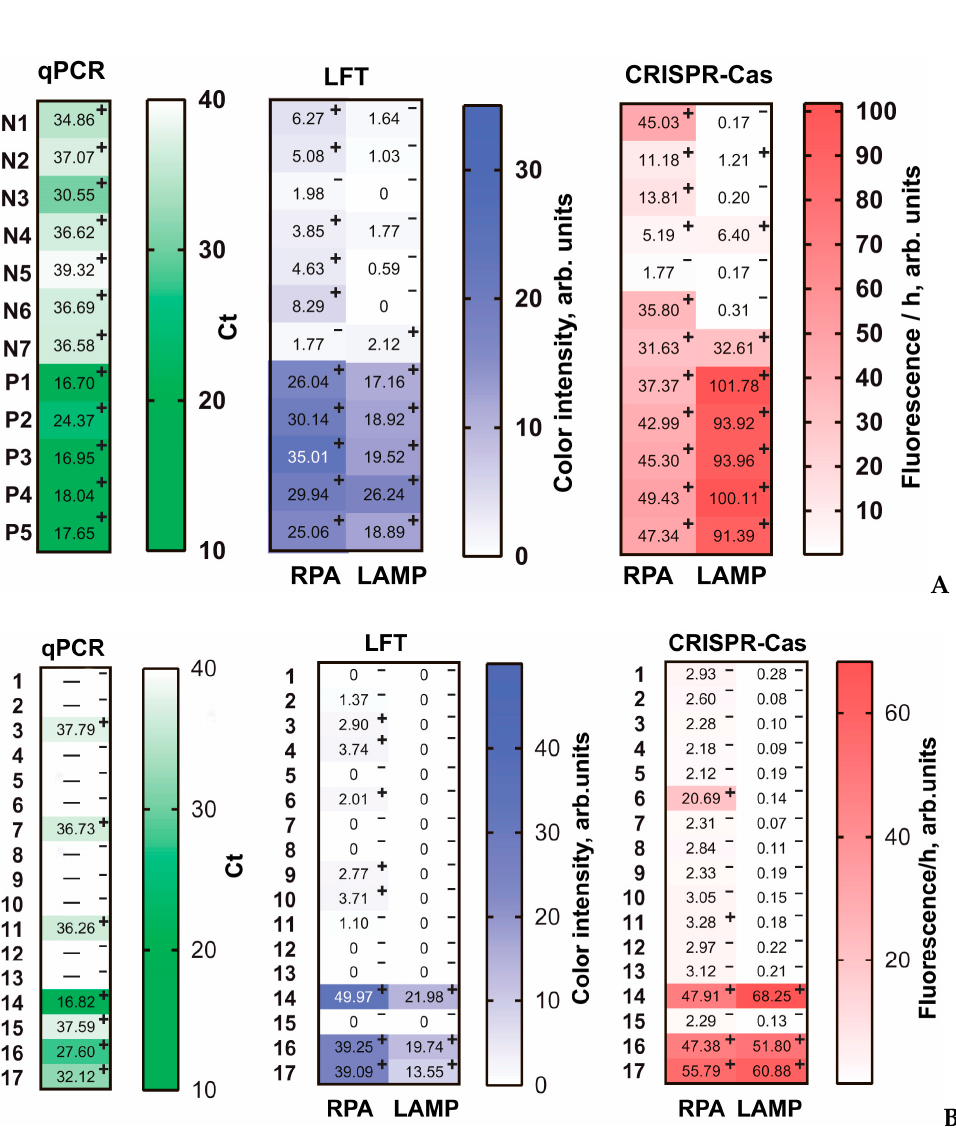
Figure 5. Detection of E. amylovora in plant leaves by qPCR, RPA-LFT, LAMP-LFT, RPA-CRISPR/Cas, and LAMP-CRISPR/Cas. The results for each sample are presented as distinct squares in the heat maps. ( A ) artificially contaminated extracts of plant samples and ( B ) real samples (dash lines in qPCR row mean no detectable signal). Positive samples are marked with “+”, negative samples are marked with “-” (cut-off for qPCR: 40; RPA-LFT and LAMP-LFT: 2.0; RPA-CRISPR/Cas: 3.18; LAMP-CRISPR/Cas: 0.34).